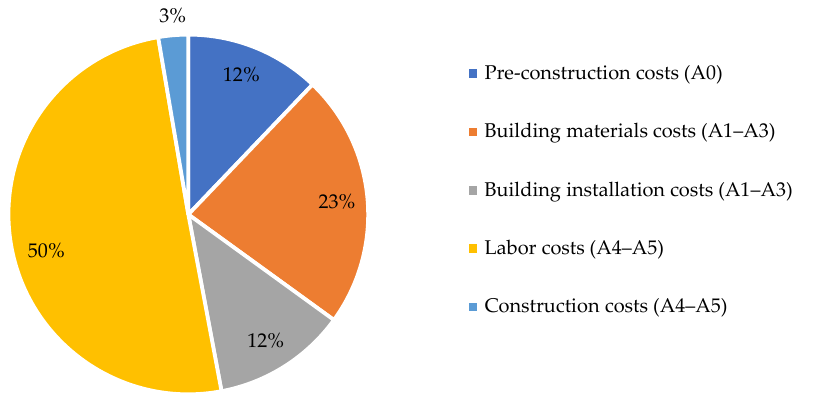
Figure 3. Breakdown of aggregated construction costs (A0–A5).